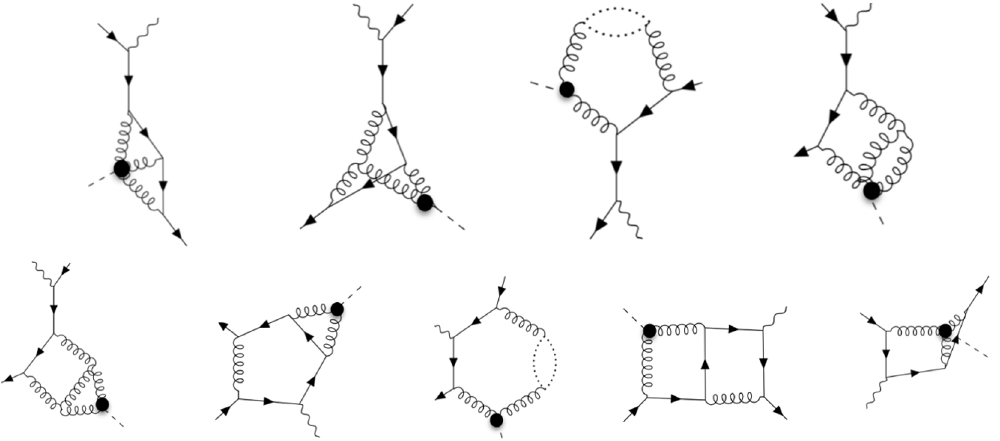
Figure 10 . Examples of the class-I two-loop diagrams proportional to (cid:21) t involving only an open massless quark line q for q (cid:22) q ! ZH in HEFT.